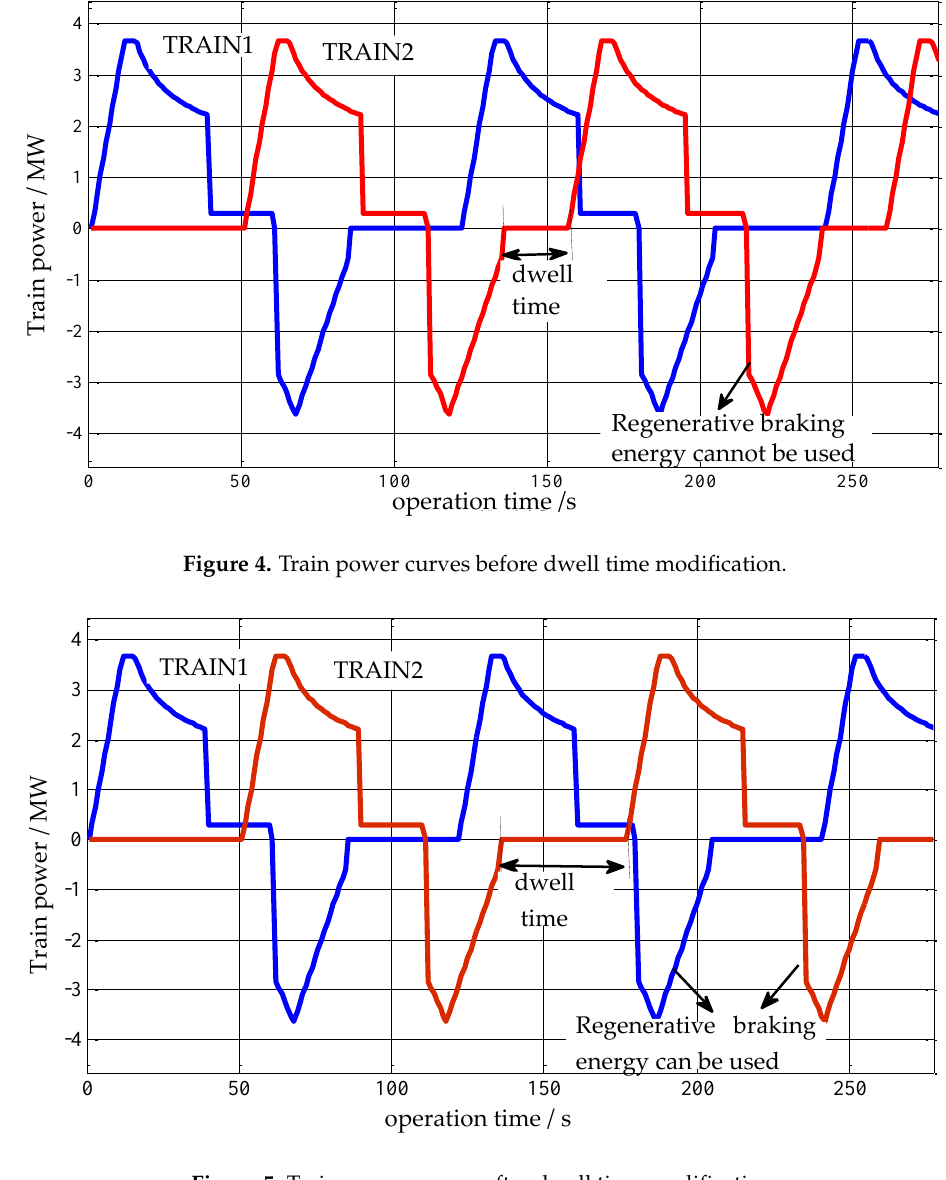
Figure 5. Train power curves after dwell time modification.